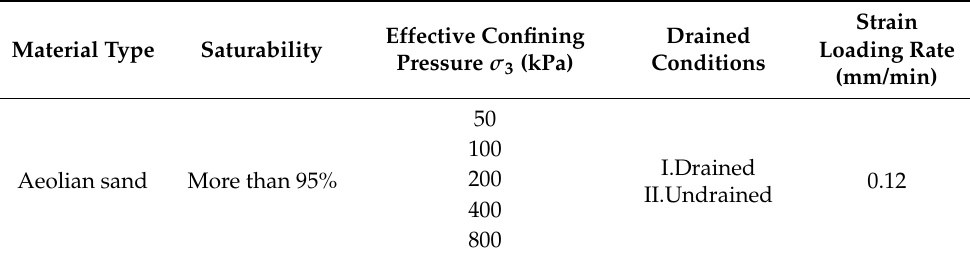
Table 2. Triaxial test control